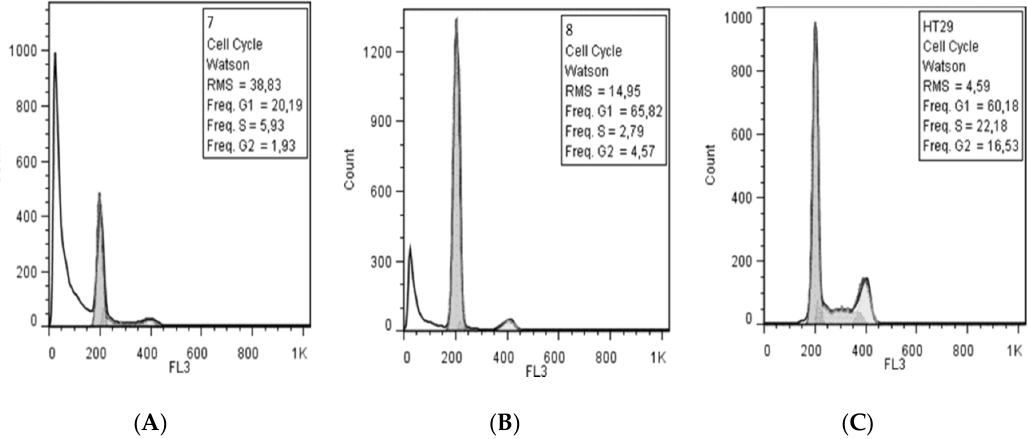
Figure 6. The influence of compounds 7 and 8 on the cell cycle in eukaryotic cells after a 48-h treatment: ( A ) compound 7; ( B ) compound 8; ( C ) control cells (HT